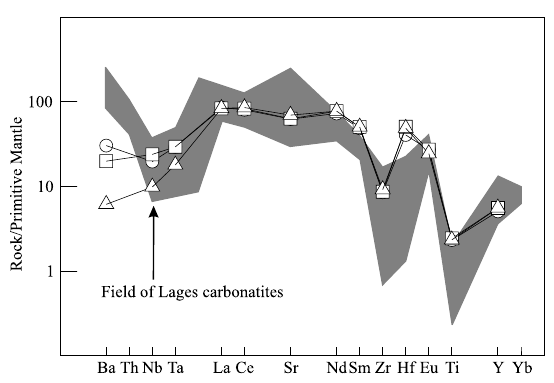
Fig. 14 – Primitive mantle normalized (Sun and McDonough 1989) REE and trace element patterns of the calculated hypothetical liquids equilibrated with the clinopyroxene megacrysts from the Janjão, Pan- dolfo and Lambedor diatremes compared with the Lages carbonatites (cf. Comin-Chiaramonti et al. 2002). Liquids were calculated from megacrysts composition using the clinopyroxene-melt partition coeffi- cients for carbonate system of Klemme et al. (1995). Symbols as in Fig. 2.